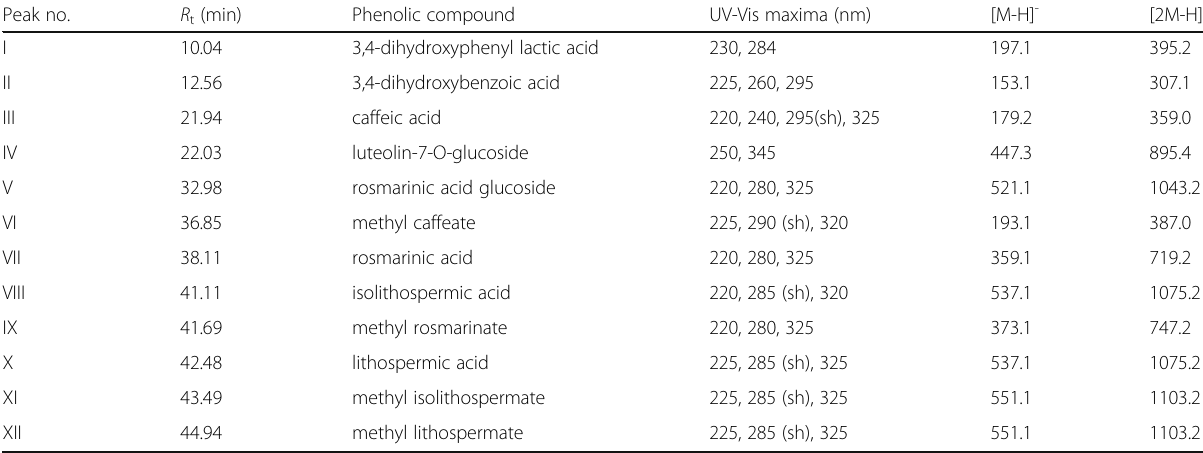
Table 1 Polyphenolic compounds identified in Melissa officinalis ethanol leaf extracts by HPLC-ESI-MS in negative ion mode Peak